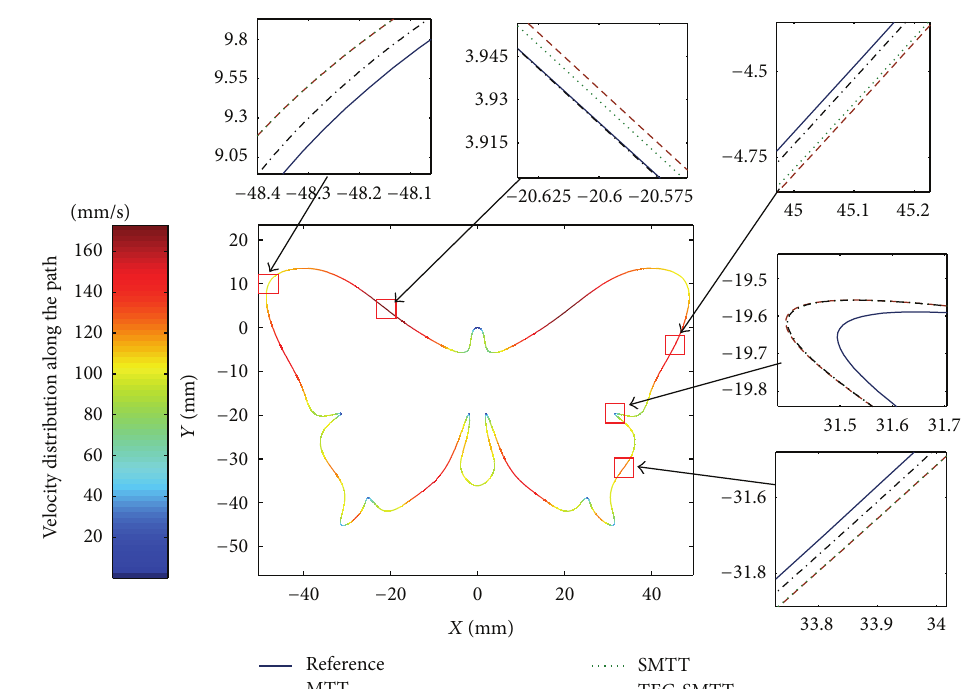
Figure 16: Simulated machining contours under the MTT (dash line), SMTT (dot line), and TEC-SMTT (dash-dot line) commands for the butterfly